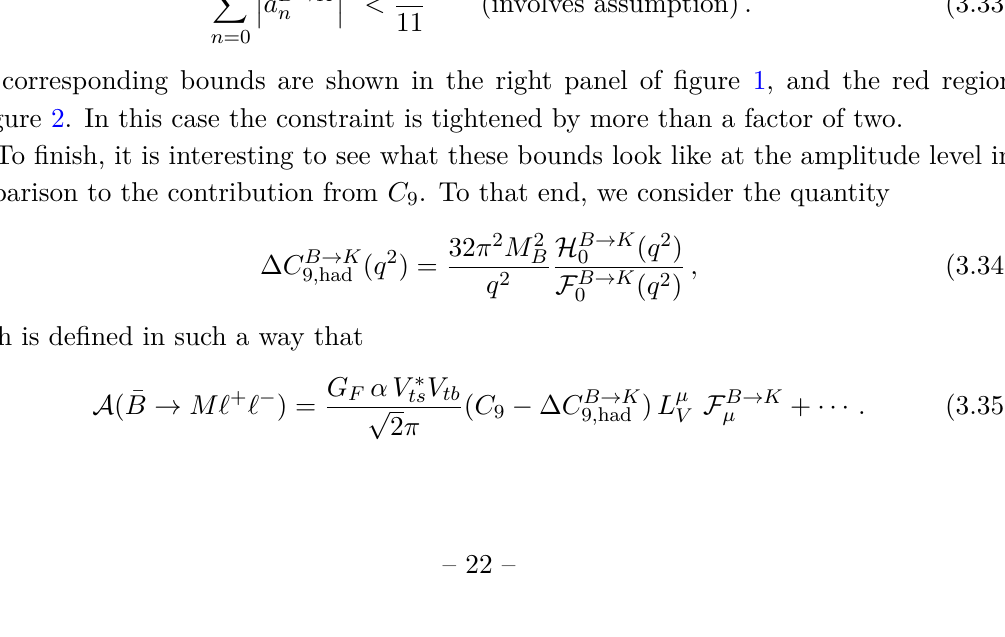
Figure 1 . Left: allowed values for the magnitude of on the expansion with one (orange), two (green) and three (blue) coefficients. The black region shows the allowed region for the three-coefficient expansion including two theory constraints at q 2 = − 1 GeV and − 5 GeV . Right: the same, assuming all contribute equally to the bound. In this case the region that includes the theory constraints is shown in